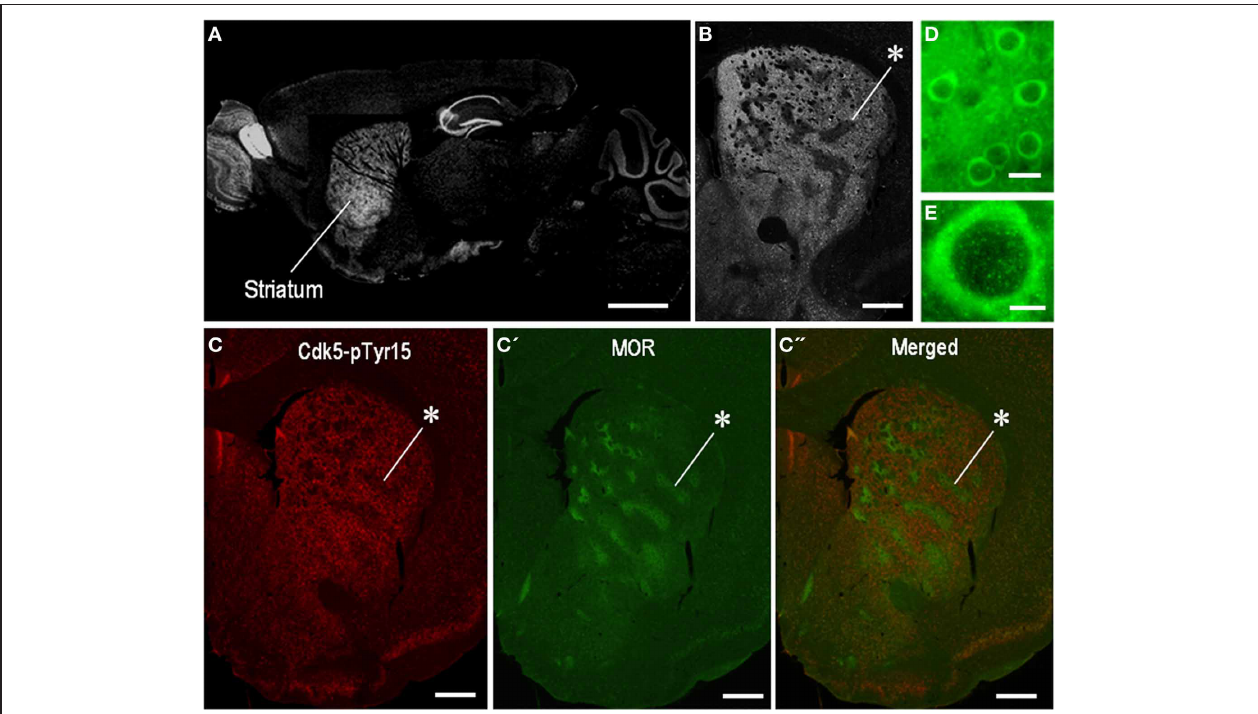
FIGURE 1 | Localization of Cdk5-p Tyr15 in the mouse striatum. (A) Photomontage of parasagittal brain sections stained for Cdk5-pTyr15. (B) Photomicrograph of a striatal section stained for Cdk5-pTyr15. Note that the matrix compartment is enriched in Cdk5-pTyr15 as compared to the striosomes. The asterisk indicates an example of striosomes poor in Cdk5-pTyr15 labeling. (C–C”) Double